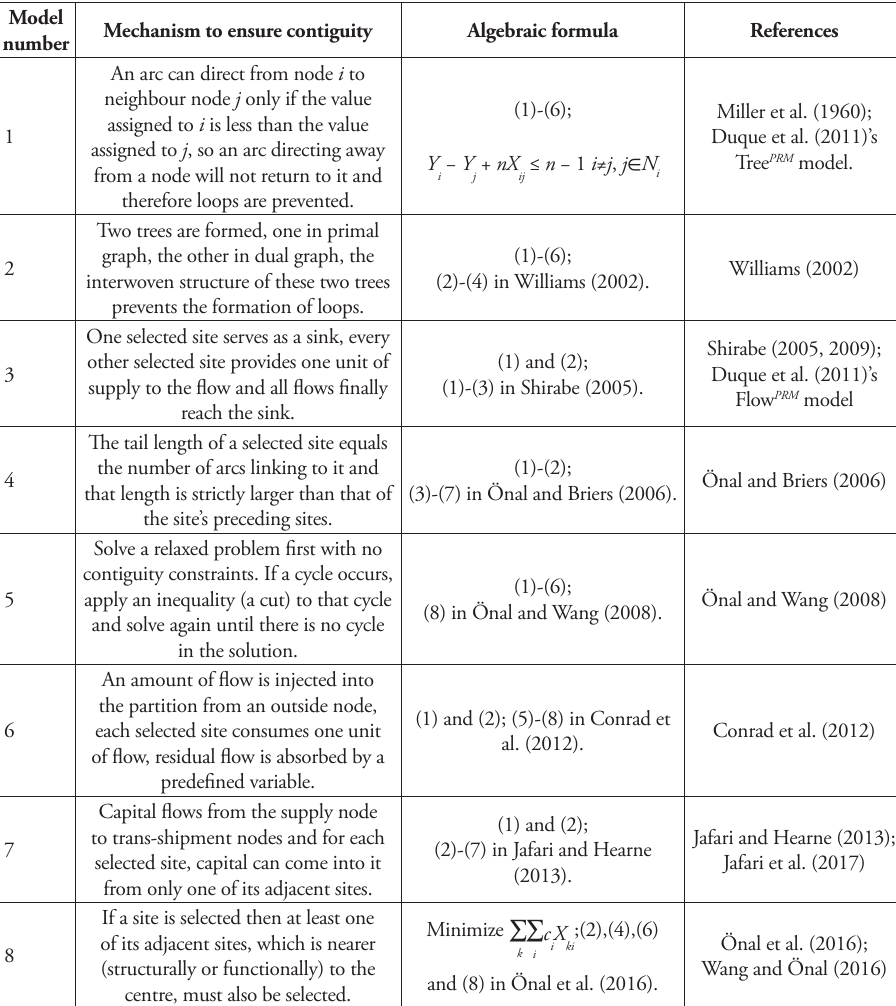
Table 1. Mechanisms used to ensure contiguity and algebraic formulae of the eight models used in the computational efficiency